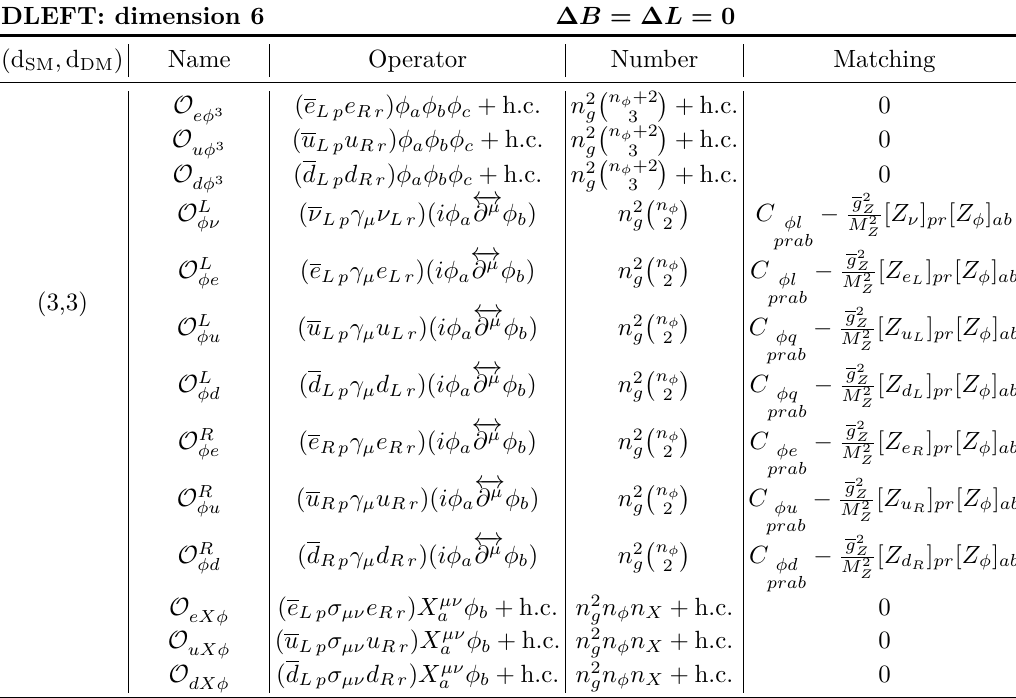
Table 21 . Dimension-six ∆ B = ∆ L = 0 operators in DLEFT, part 2. The first column gives the dimensions of the SM and DM part of the operator, the fourth column is the number of operators, and the fifth column is the additional matching contribution at the EW